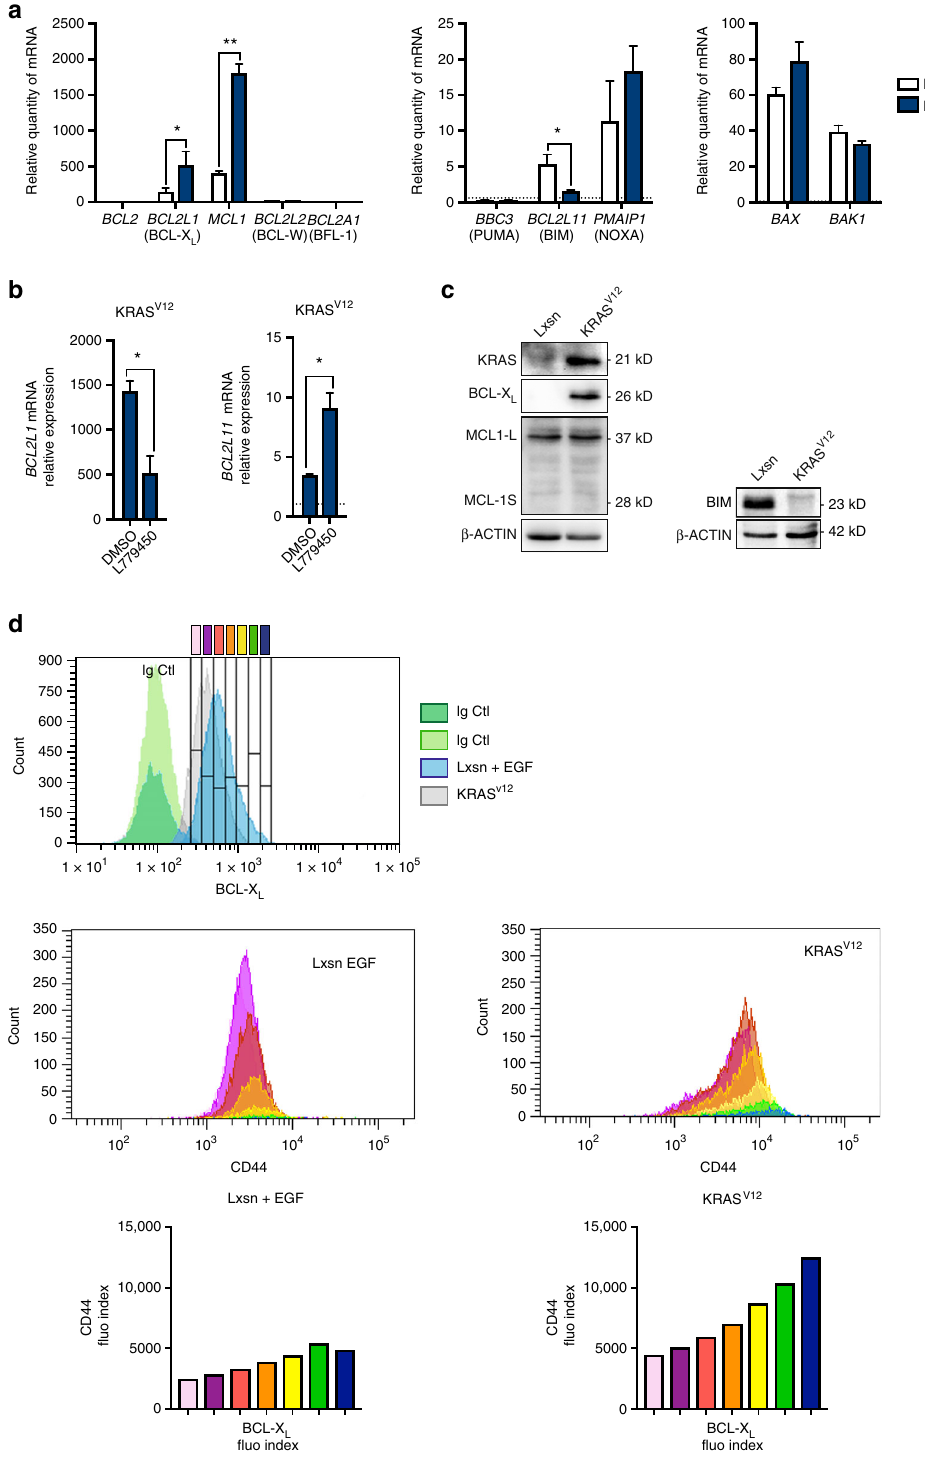
Fig. 1 Oncogenic RAS induces BCL-XL expression correlated with enhanced CD44 expression. a qPCR analysis of BCL2 family member mRNA expression in MCF10A Lxsn and KRAS V12 cell lines grown in adherent conditions. Mean and SEM of 3 independent experiments are represented as relative quantity of mRNA normalised to the mean of RPLP0 , RPS18 and B2M relative expression (two-tailed unpaired t -test). b Western blot showing KRAS, BCL-X L , MCL-1 and BIM expression in MCF10A Lxsn and KRAS V12 cell lines. c qPCR analysis of BCL2L1 and BCL2L11 mRNA expressed in MCF10A KRAS V12 cell line treated with 10 μ M of RAF inhibitor (L779450). Mean and SEM of three independent experiments are represented as relative quantity of mRNA normalised to the mean of RPLP0 , RPS18 and B2M relative expression (two-tailed unpaired t -test). d Flow cytometry analysis of a co-staining for intracellular BCL-X L and cell surface CD44. Expression of CD44 (middle and bottom) is shown in populations of increasing levels of BCL-X L as evaluated in Top panel (grey, EGF treated Lxsn cells, blue, KRAS V12 cell). Stainings with control isotypes are shown in green. Data from one representative experiment are